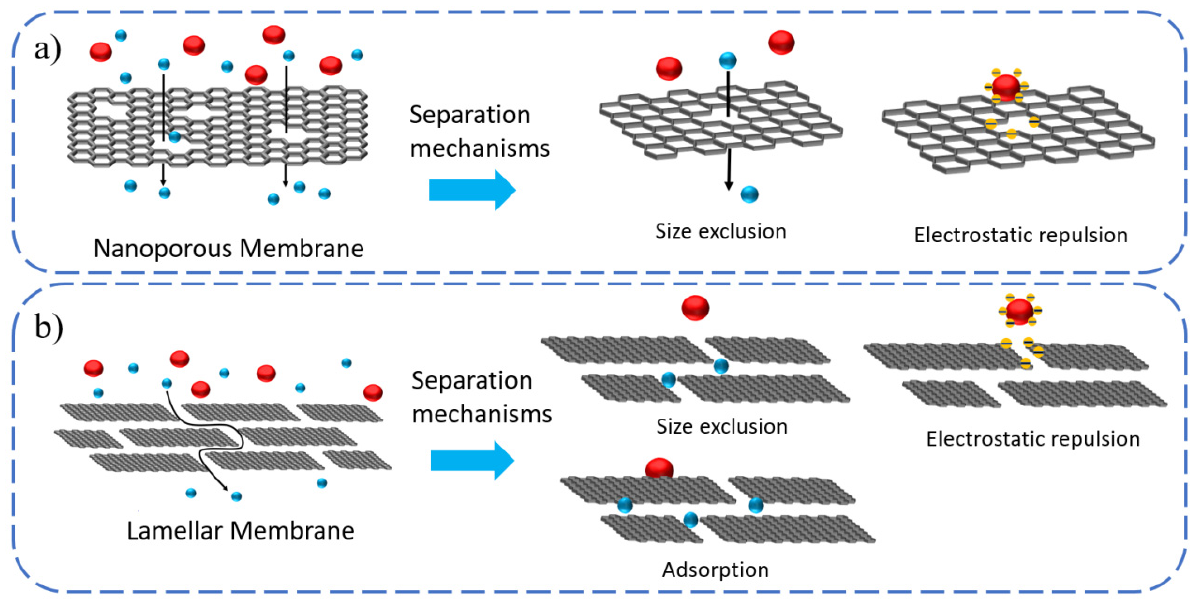
Figure 1. Schematic representation of the two types of 2DNM-based membranes. ( a ) Nanoporous membranes consist of a single layer of 2D material flakes with nanopores of precisely defined pore size. Selectivity is achieved by size exclusion and electrostatic repulsion between the charged species and the pores. ( b ) Membranes composed of stacked 2D material flakes. In stacked 2DNM membranes, the size of the pores is determined by the interlayer spacing between the flakes. In addition to size exclusion and electrostatic interaction, selectivity in-stacked 2DNM-based membranes also result from ion adsorption via electrostatic binding.